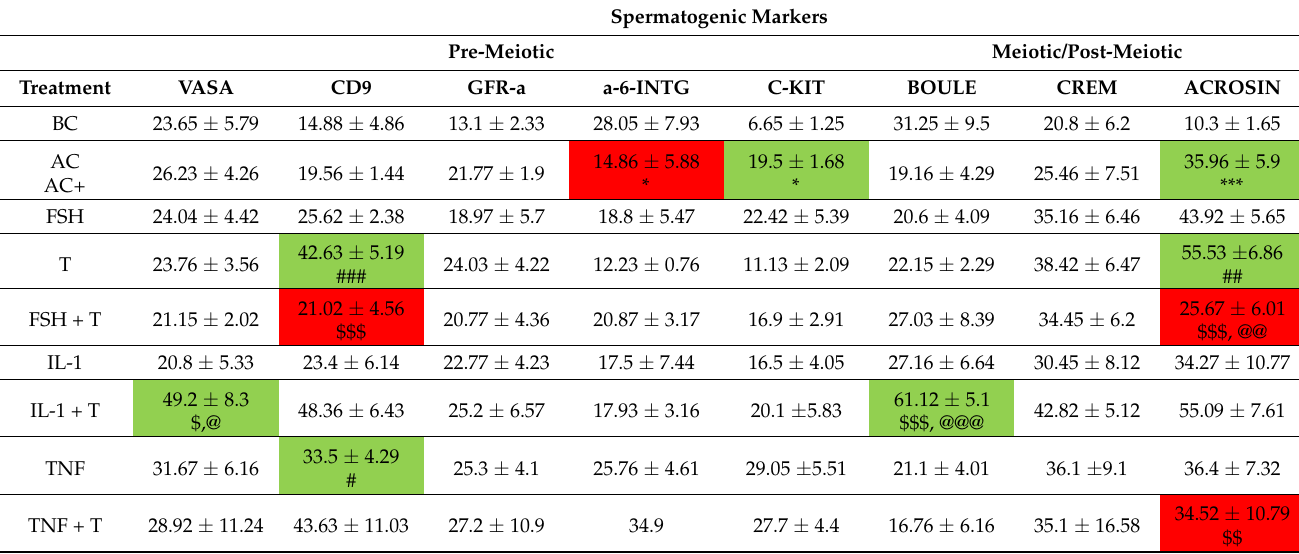
Table 1. Effect of hormones (FSH and testosterone) and cytokines (IL-1 α and TNF α ) on the proliferation and differentiation of spermatogonial cells isolated from CP-treated immature mice cultured in vitro in